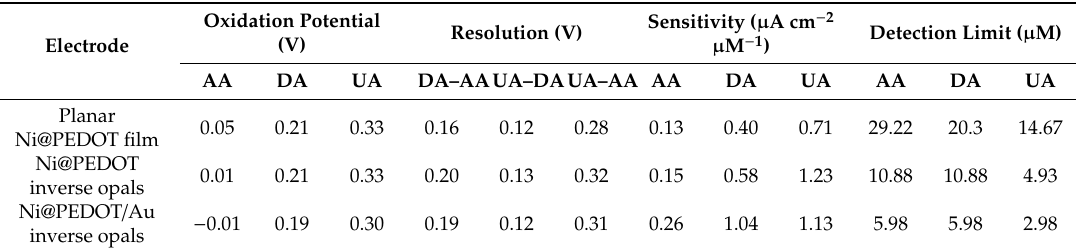
Table 4. The oxidation potential and resolution for sensing AA, DA, and UA from planar